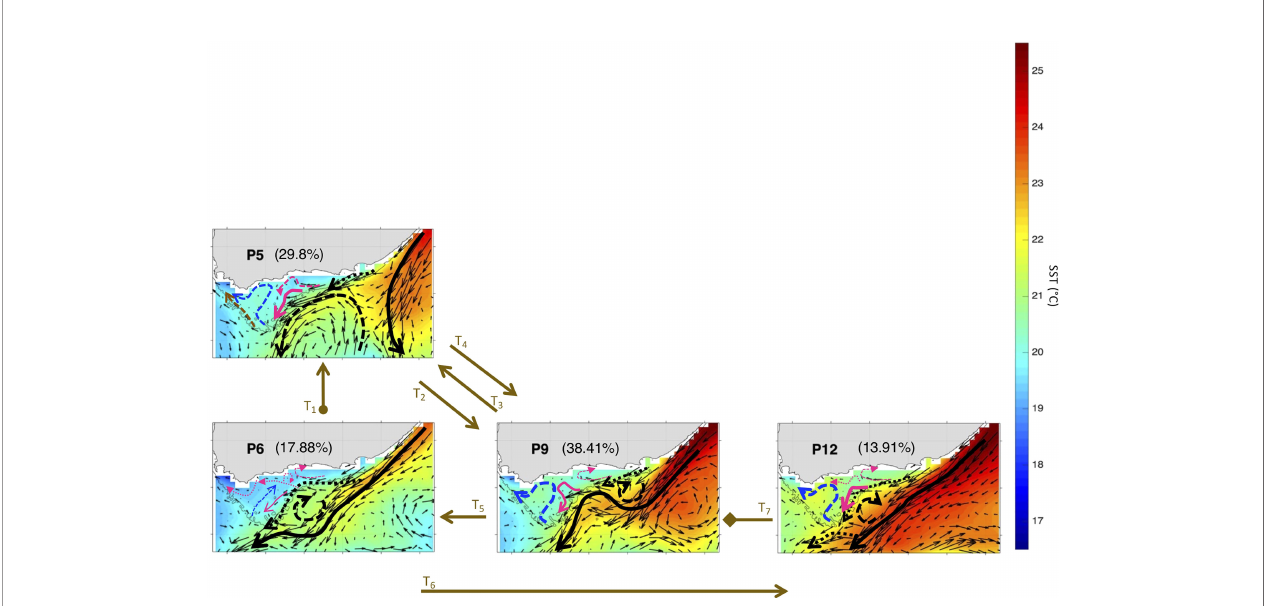
FIGURE 8 | Same as Figure 3 but for Nov-Mar 2000-01. The frequency of occurrence of each pattern is calculated here relative to the days recorded during Nov-Mar 2000-01. The brown arrows represent the SOM patterns trajectories (T i=1:7 ) evolving during Nov-Mar 2000-01 as inferred from the BMU timeseries ( Supplementary Figure 4A ). The starting ( fi nal) trajectory is designated with a circle (diamond) at the arrow beginning